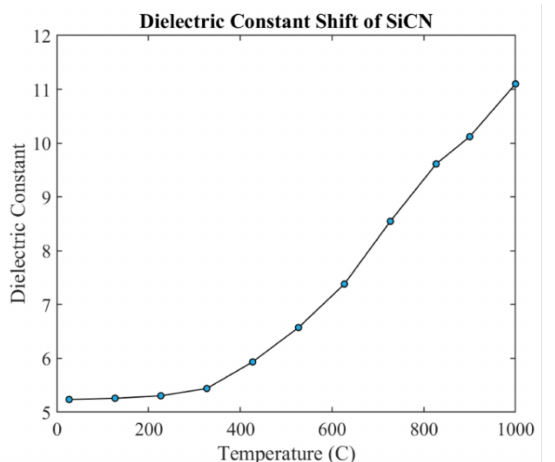
Figure 16. The measurement result of SiCN dielectric constant with increasing temperature.